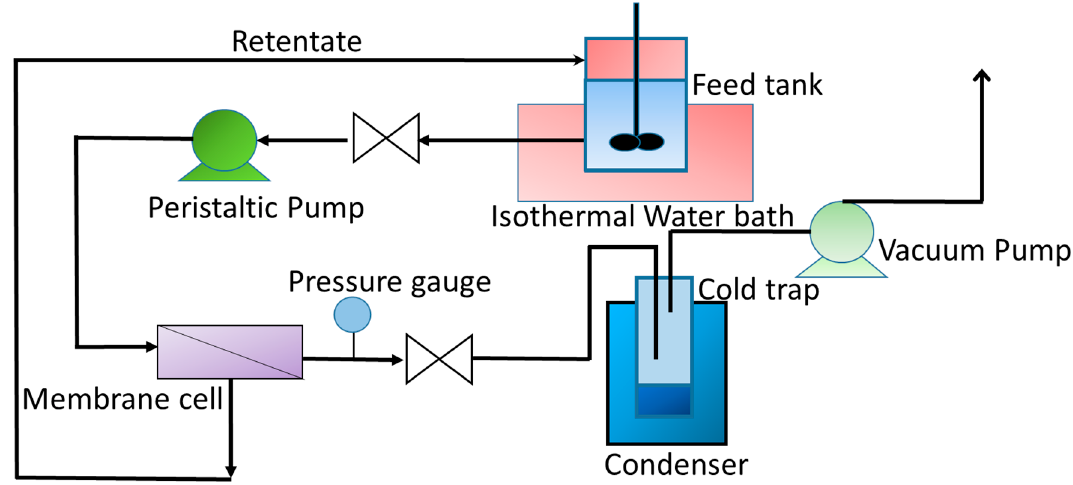
Figure 1. Schematic of PV experimental setup.